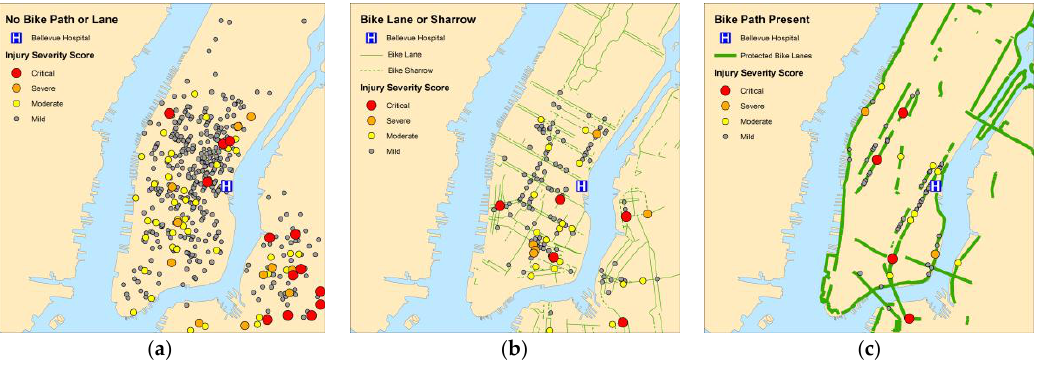
Figure 2. Comparison of ISS based on presence or absence of bicycle routes. Legend: Maps of injury severity scores (ISS) for bicyclists struck by motor vehicles based on ( a ) absence of bicycle lane/path; ( b ) presence of sharrow or painted bicycle lane; and ( c ) presence of physically protected path. ISS is color-coded based on severity: critical (red), severe (orange), moderate (yellow), and mild (gray).